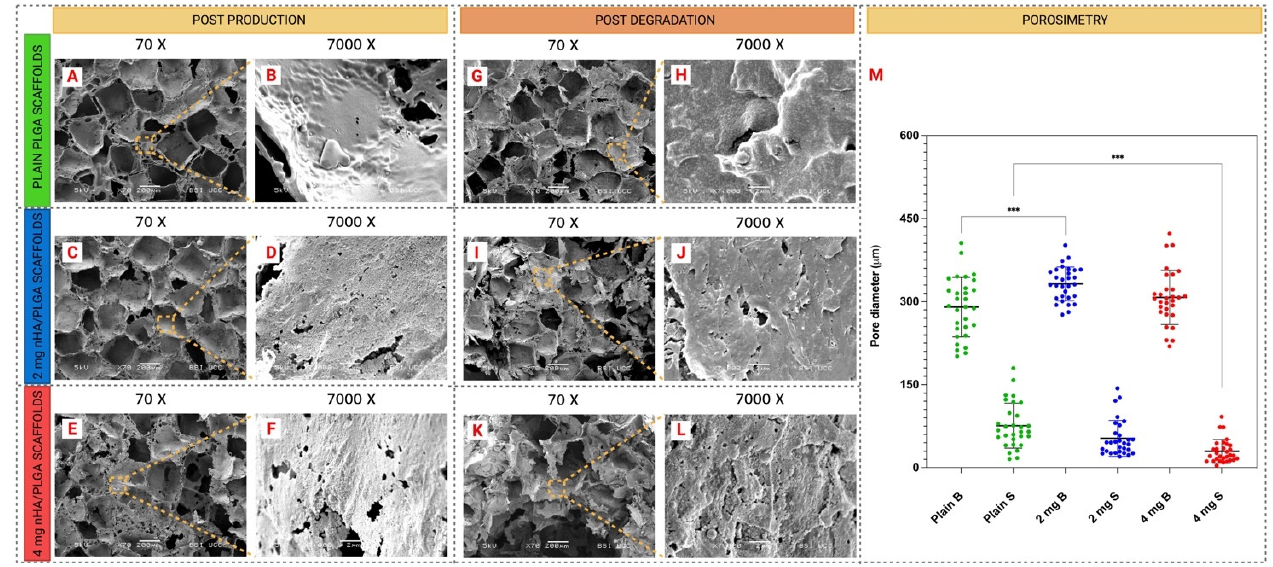
Figure 2. Representative SEM images of the different scaffolds after production (t = 0) and after the degradation study at t = 35 days (magnifications ×70 and ×7000): ( A , B , G , H ) PLGA scaffolds, ( C , D , I , J ) 2 mg nHA/PLGA scaffolds; and ( E , F , K , L ) 4 mg nHA/PLGA scaffolds. The scaffolds were cut longitudinally and imaged at different magnifications to check the inner architecture of the pores and the distribution of nHA in the scaffolds. Scale bars are 200 μ m and 2 μ m. ( M ) Porosimetry data of large pores, (indicated by B on the y-axis in 2M) and small pores (indicated by S on the y-axis in 2M) in the different scaffolds after foaming and leaching (t = 0). *** p < 0.001.